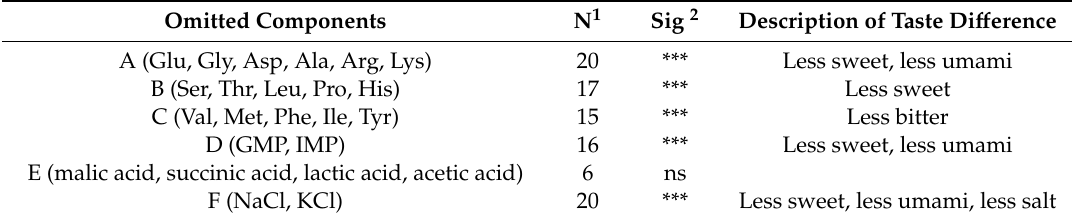
Table 2. Results of the first omission tests.